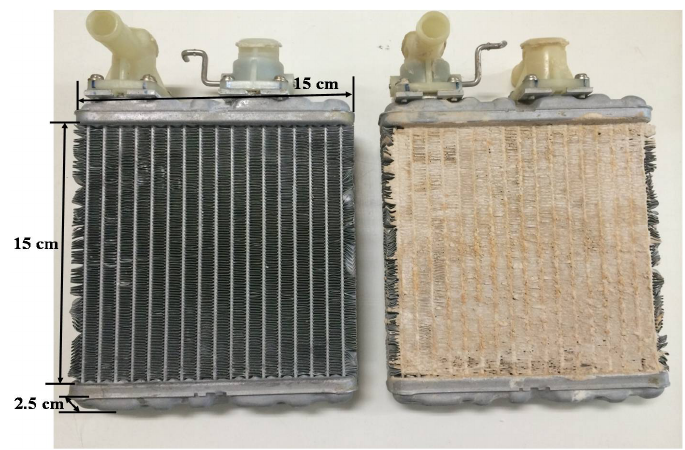
Figure 1. Corrugated heat exchanger before being coated ( left ), and after being coated ( right ) with Wakkanai Siliceous Shale (WSS) + 40 wt. % lithium chloride (LiCl). Table 2. Main features of the sorbent coated heat exchangers in the reactor. Parameters Value